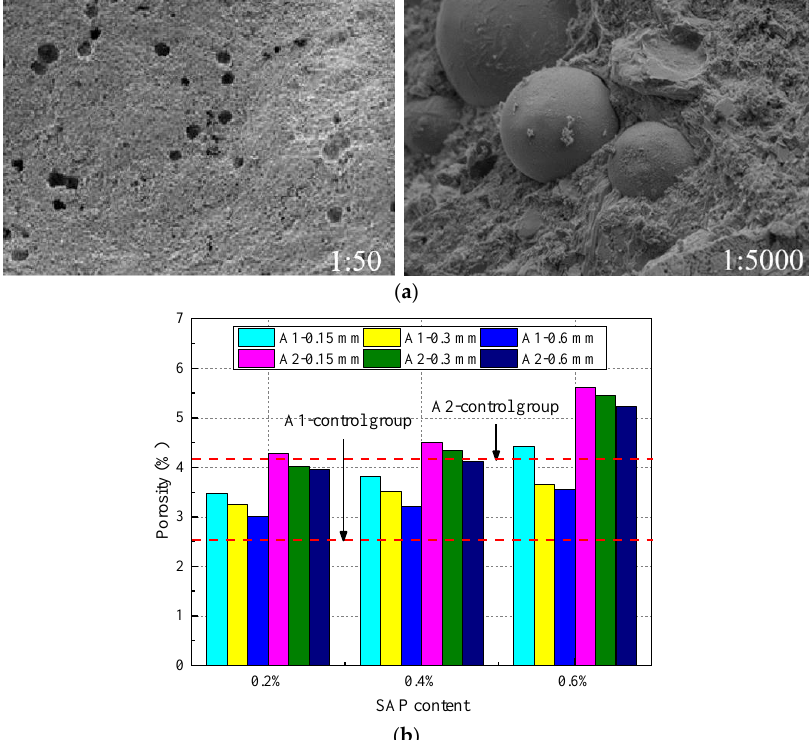
Figure 16. The porosity of concrete under different water–cement ratios: ( a ) SEM image of concrete with addition of SAP; Reprinted from ref. [3]. ( b ) different SAP contents.